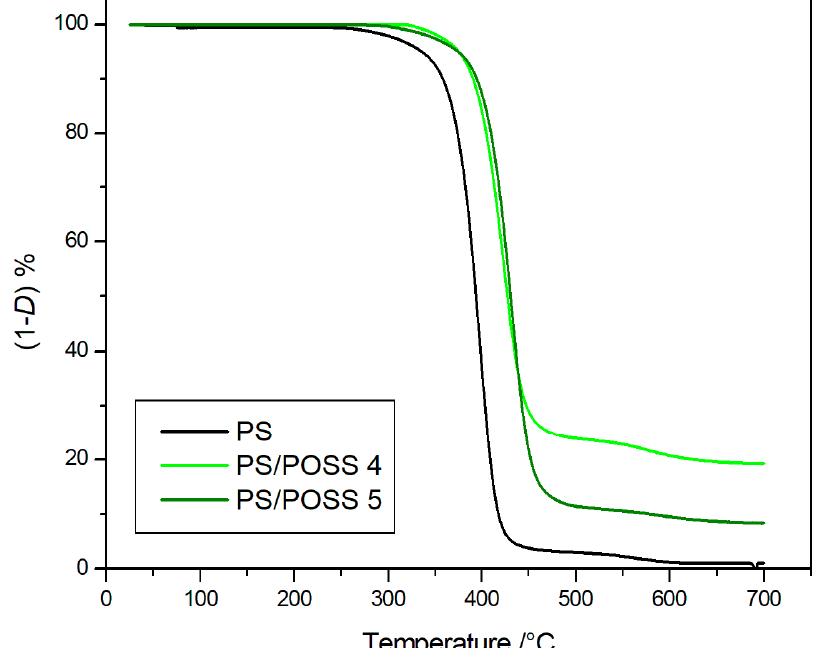
Figure 2. Thermogravimetric curves, in an inert atmosphere, for PS and samples 1 , 2 and 3 .